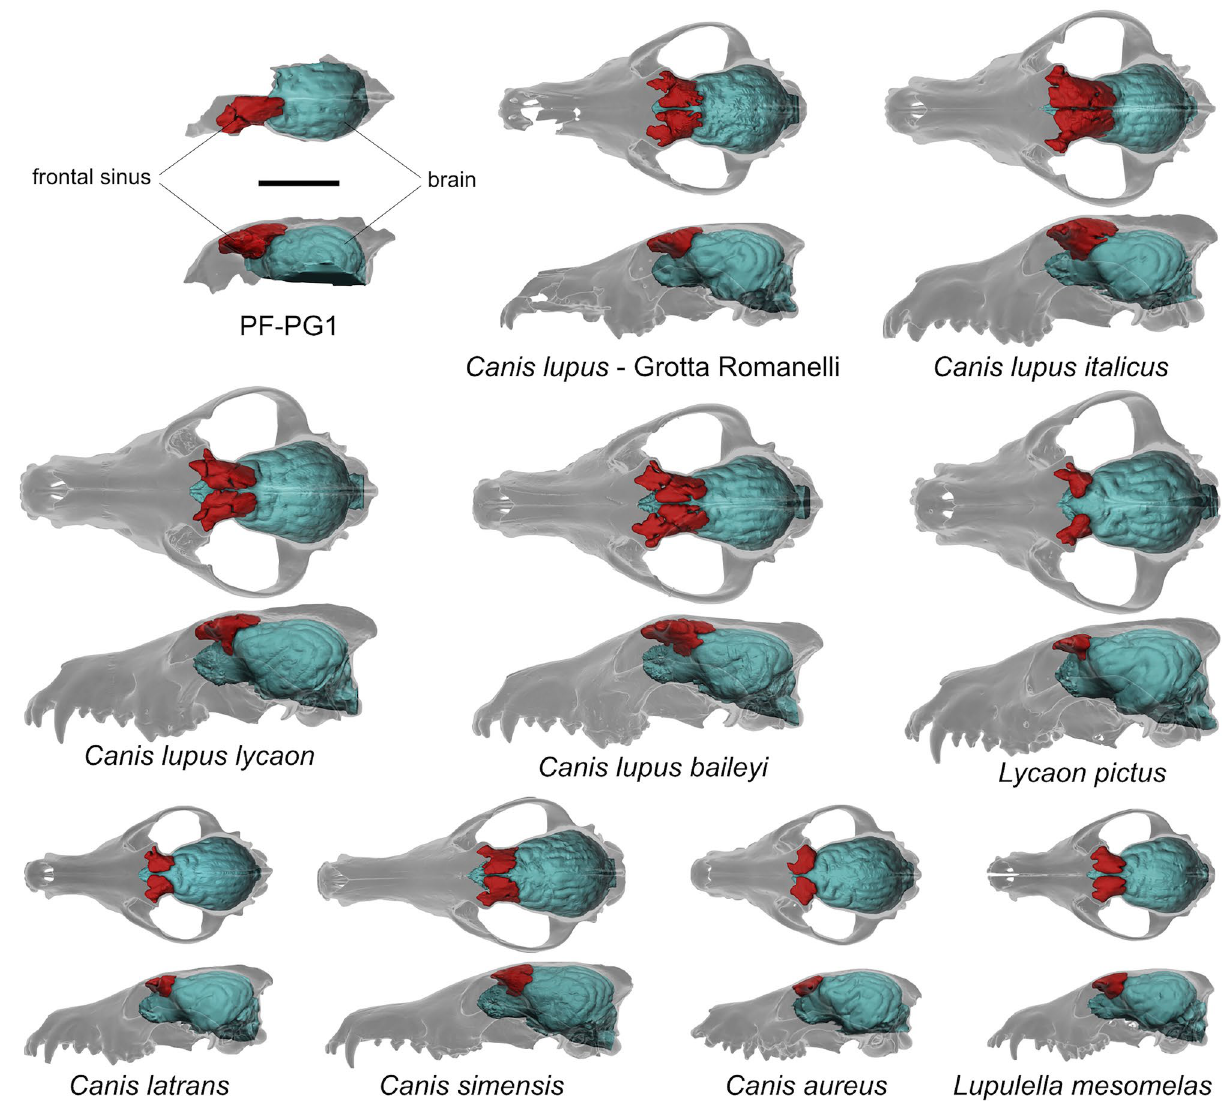
Figure 6. Comparative morphology of the frontal sinuses of PF-PG1 from Ponte Galeria and a selected sample of fossil and extant canids (the complete list of specimens is reported in Supplementary Table S4). Sale bar: 50